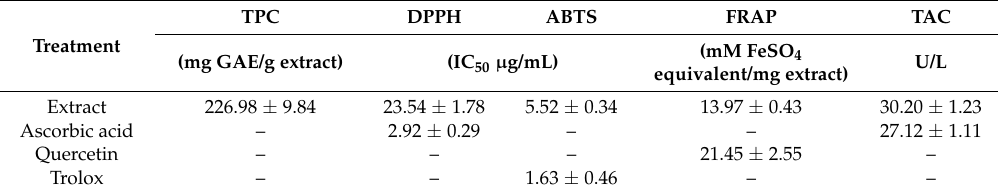
Table 2. Total phenolic content (TPC) and in vitro antioxidant activities of the methanol extract of A. zerumbet leaves. Ascorbic acid, quercetin and trolox were used as positive controls. TPC Treatment Extract